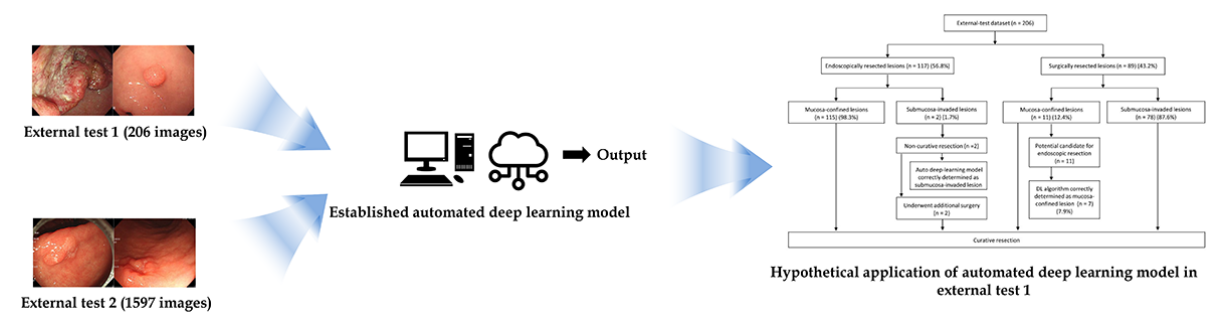
Figure 2. Schematic flow for the establishment of automated deep learning models in performance evaluation.